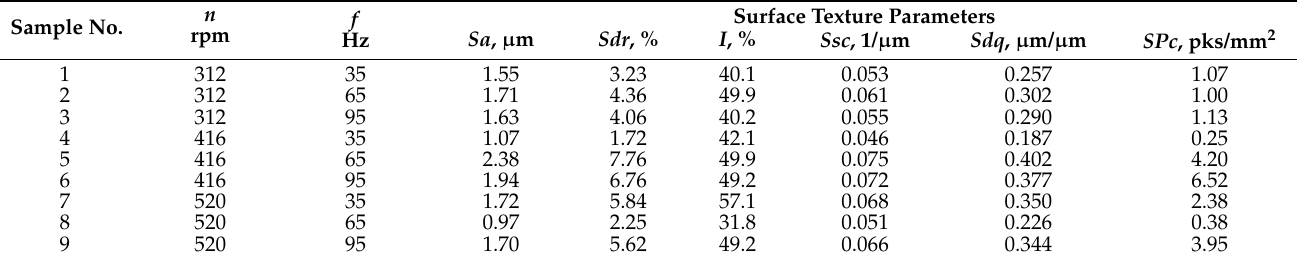
Table 3. Selected results obtained during the second stage of experimental research. Sample